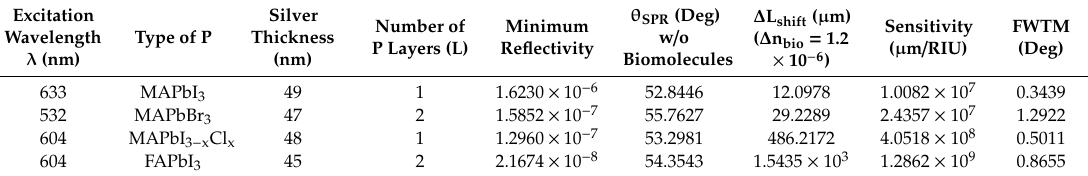
Table 3. Summary of the conditions for each type of 2D perovskite to achieve the largest Goos–Hänchen lateral shift while simultaneously with high